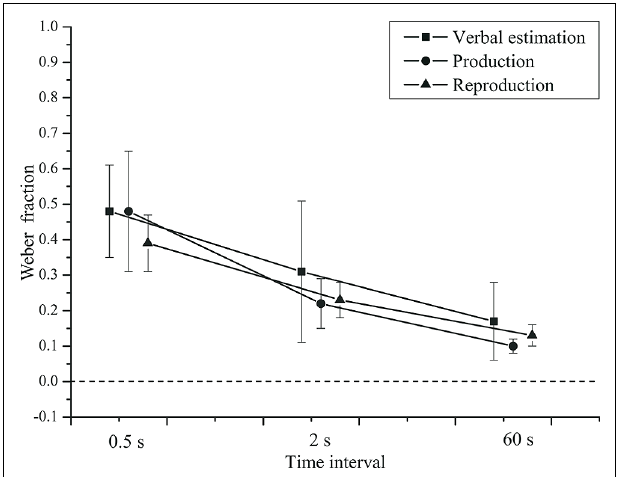
FIGURE 3 | MeanWeber fractions as a function of time interval and task. Error bars: 95%